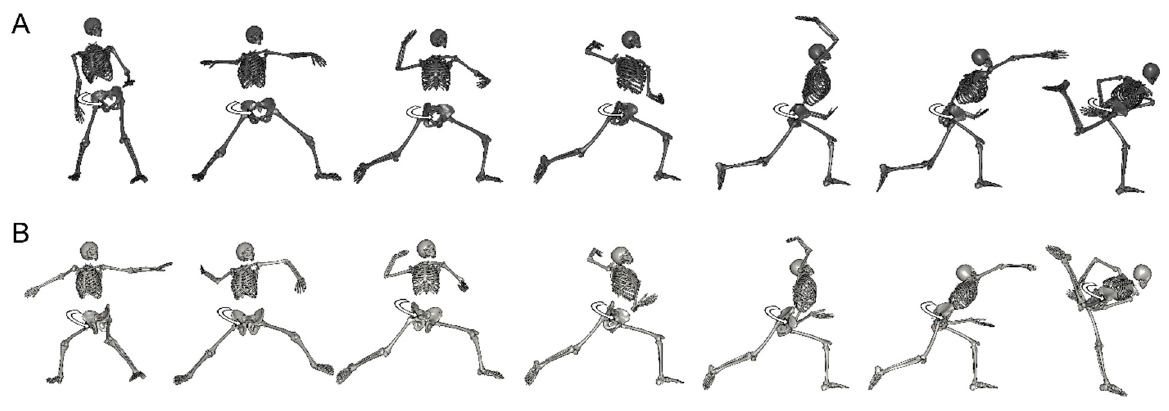
Figure 5. The pitching form of the representative example watched from third base ( A ): women/horizontal rotational movement, ( B ): men/oblique rotational movement.